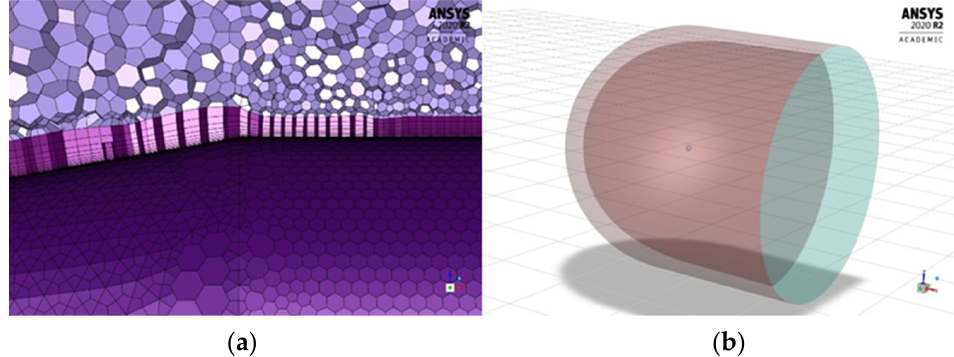
Figure 6. Details of: ( a ) Prism boundary layer at nose-body conjunction; ( b ) far-field with small dynamic mesh sphere zone in the middle.